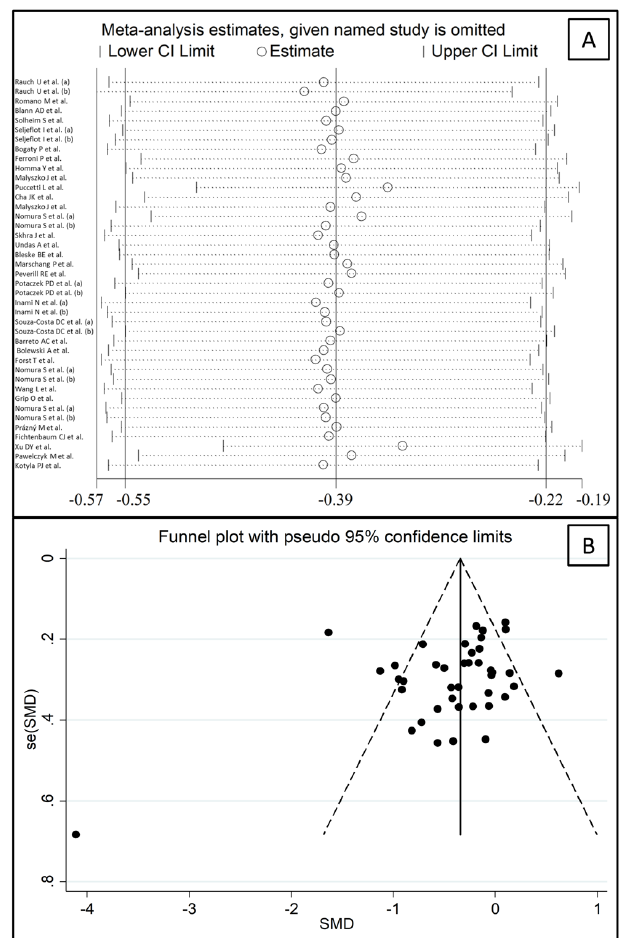
Figure 3. ( A ) Sensitivity analysis of the association between P-Selectin and statin treatment. The influence of individual studies on the overall standardized mean difference (SMD) is shown. The middle vertical axis indicates the overall SMD, and the two vertical axes indicate the 95% confidence intervals (CIs). The hollow circles represent the pooled SMD when the remaining study is omitted from the meta-analysis. The two ends of each broken line represent the 95% CIs. ( B ) Funnel plot of studies investigating P-Selectin concentrations before and after statin treatment.